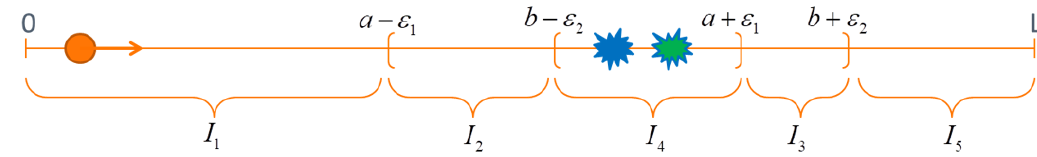
Fig. 2. Schematic presentation of the model system with two targets